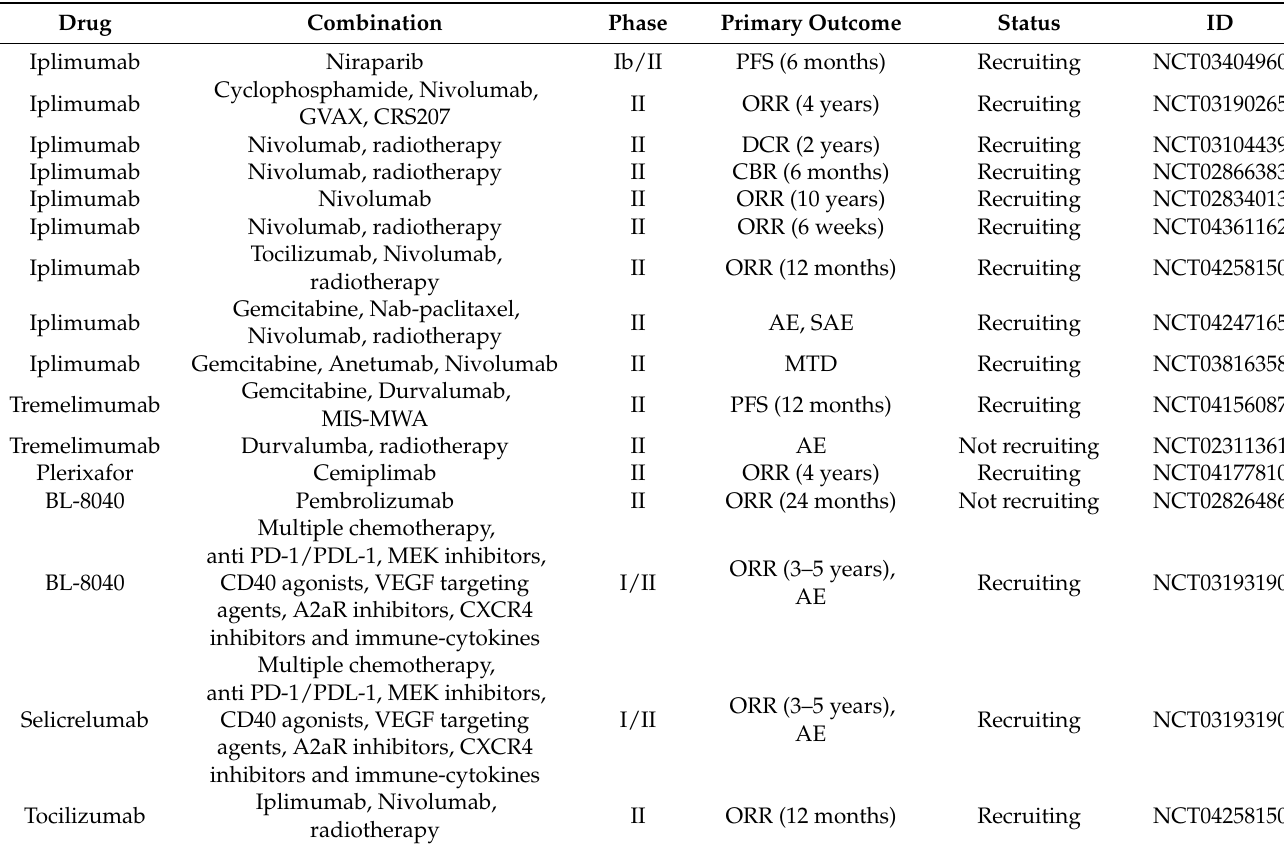
Table 9. Clinical trials testing immunotherapy agents for pancreatic